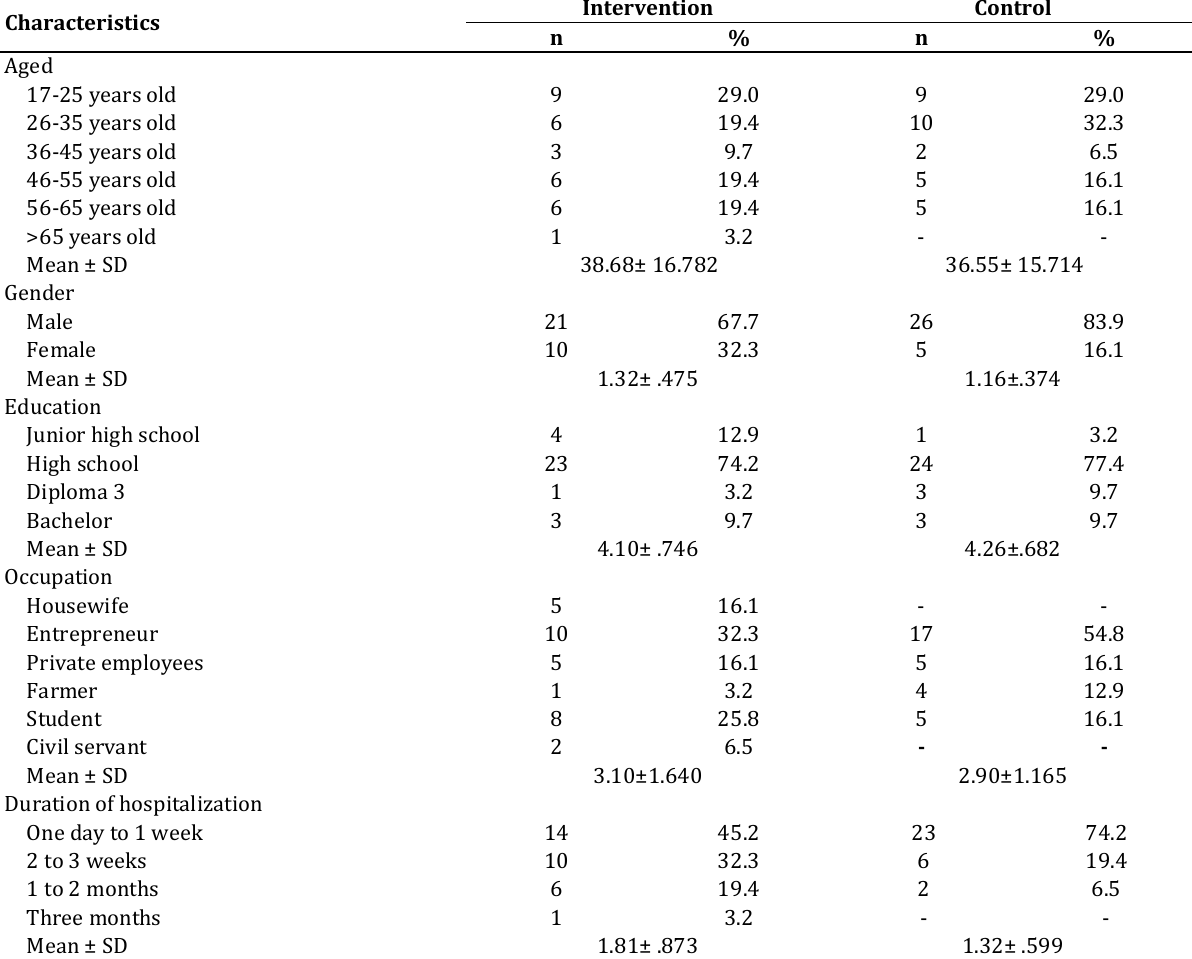
Table 1. The Distribution of Frequency and Percentage of Characteristic Demographic Data among the Intervention and the Control Group (n=62) Characteristics